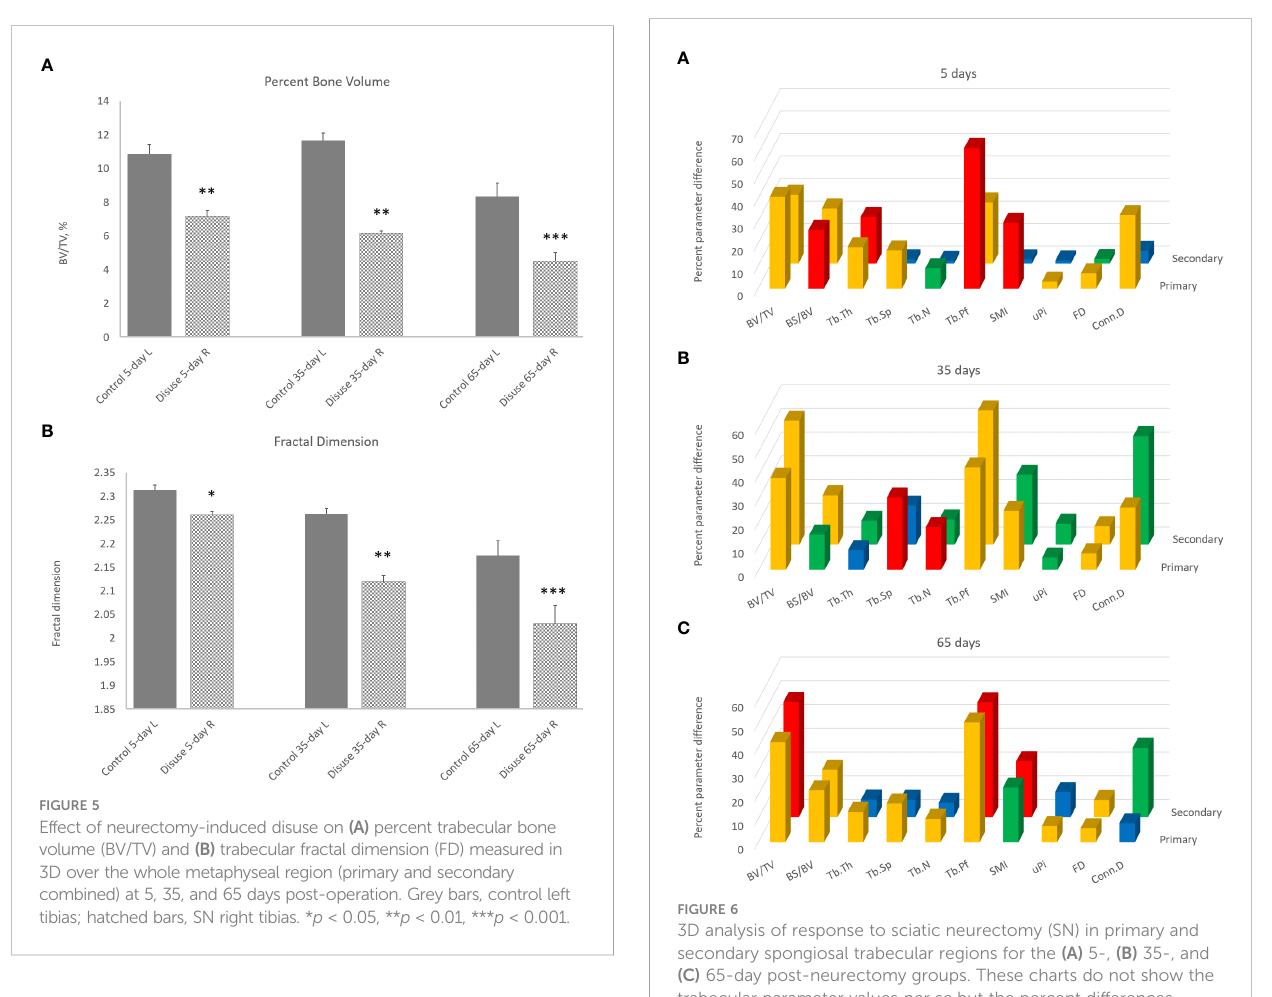
FIGURE 6 3D analysis of response to sciatic neurectomy (SN) in primary and secondary spongiosal trabecular regions for the (A) 5-, (B) 35-, and (C) 65-day post-neurectomy groups. These charts do not show the trabecular parameter values per se but the percent differences between the neurectomised right and control left tibias (made positive) for each parameter. The two rows of bars denote the primary spongiosa in front and the secondary spongiosal region behind. Colour coding of the bars is according to the p -values of the SN-contralateral differences from the Student ’ s T -test (paired, heteroscedastic). Blue: p > 0.05; green: p < 0.05, p > 0.01; orange: p < 0.01, p > 0.001; red: p < 0.001.